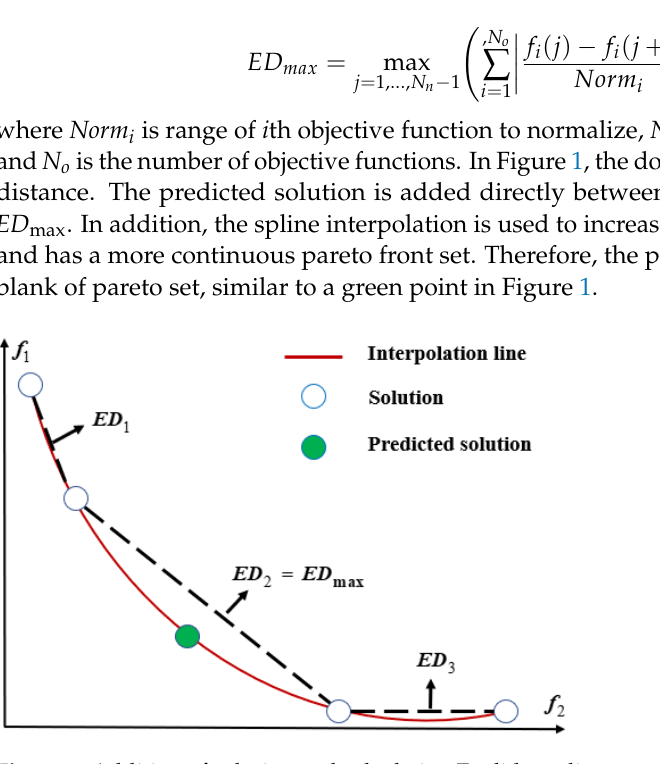
Figure 1. Addition of solution and calculation Euclidean distance.